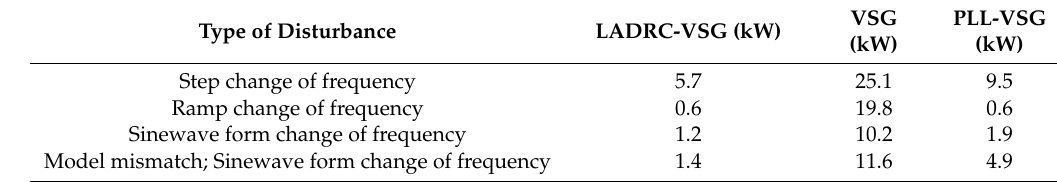
(2.5–3 s, one decimal place reserved). e